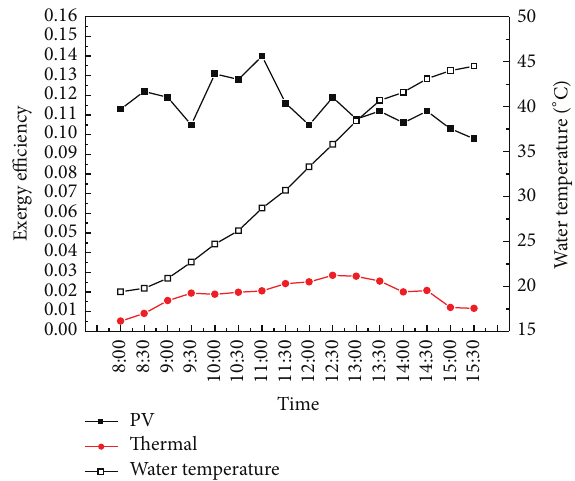
Figure 6: Exergy efficiency with water temperature variation during the test.